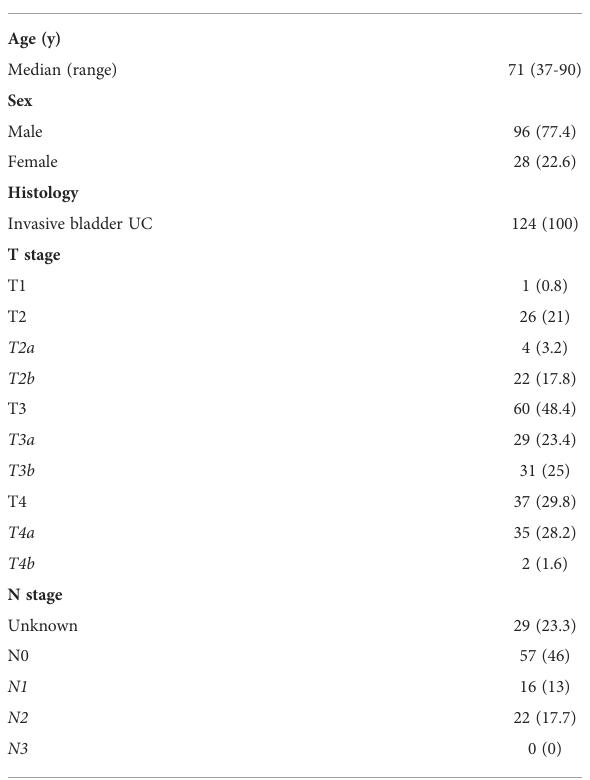
TABLE 1 Clinicopathological characteristics of